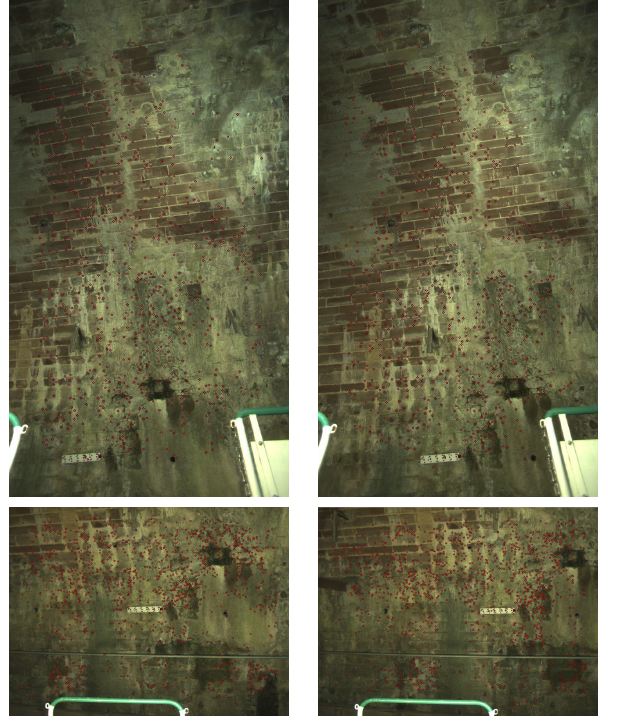
Figure 9: Successive views of the vaults (top) and side wall (bot- tom) at time t (left) and t + 1 (right). Smartpoints that have been automatically detected for bundle adjustment are superimposed upon the images (in red).